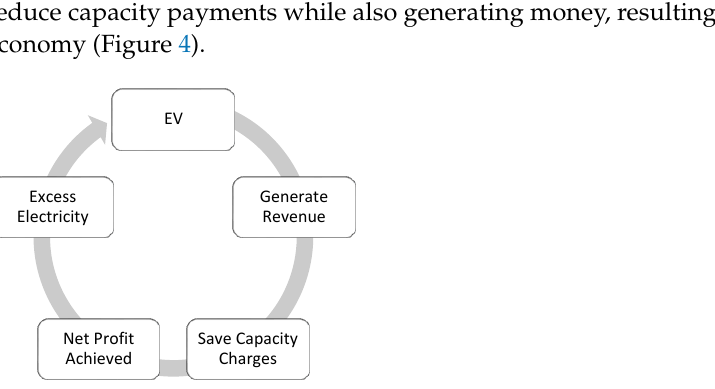
Figure 4. Revenue generation from EV deployment [12].